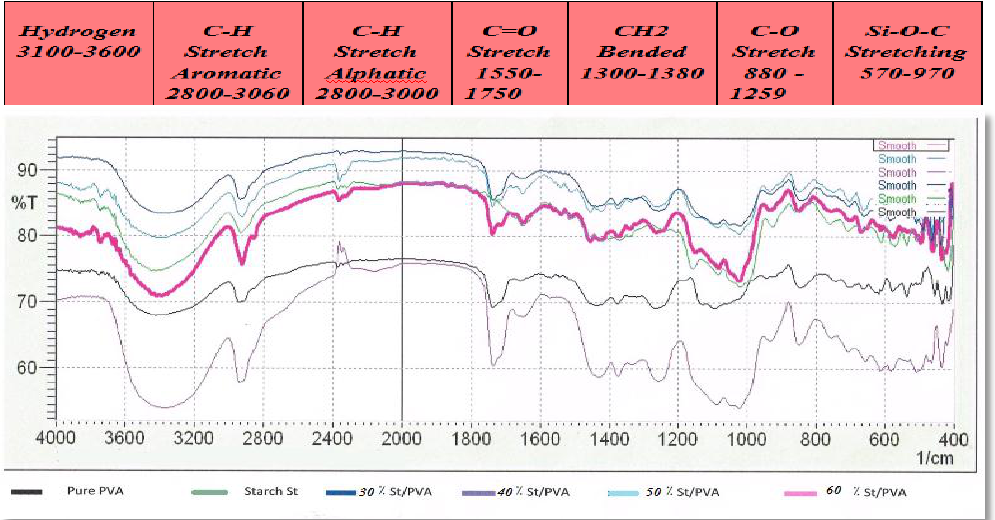
Fig. 8: FTIR spectra of St/PVA blend films.